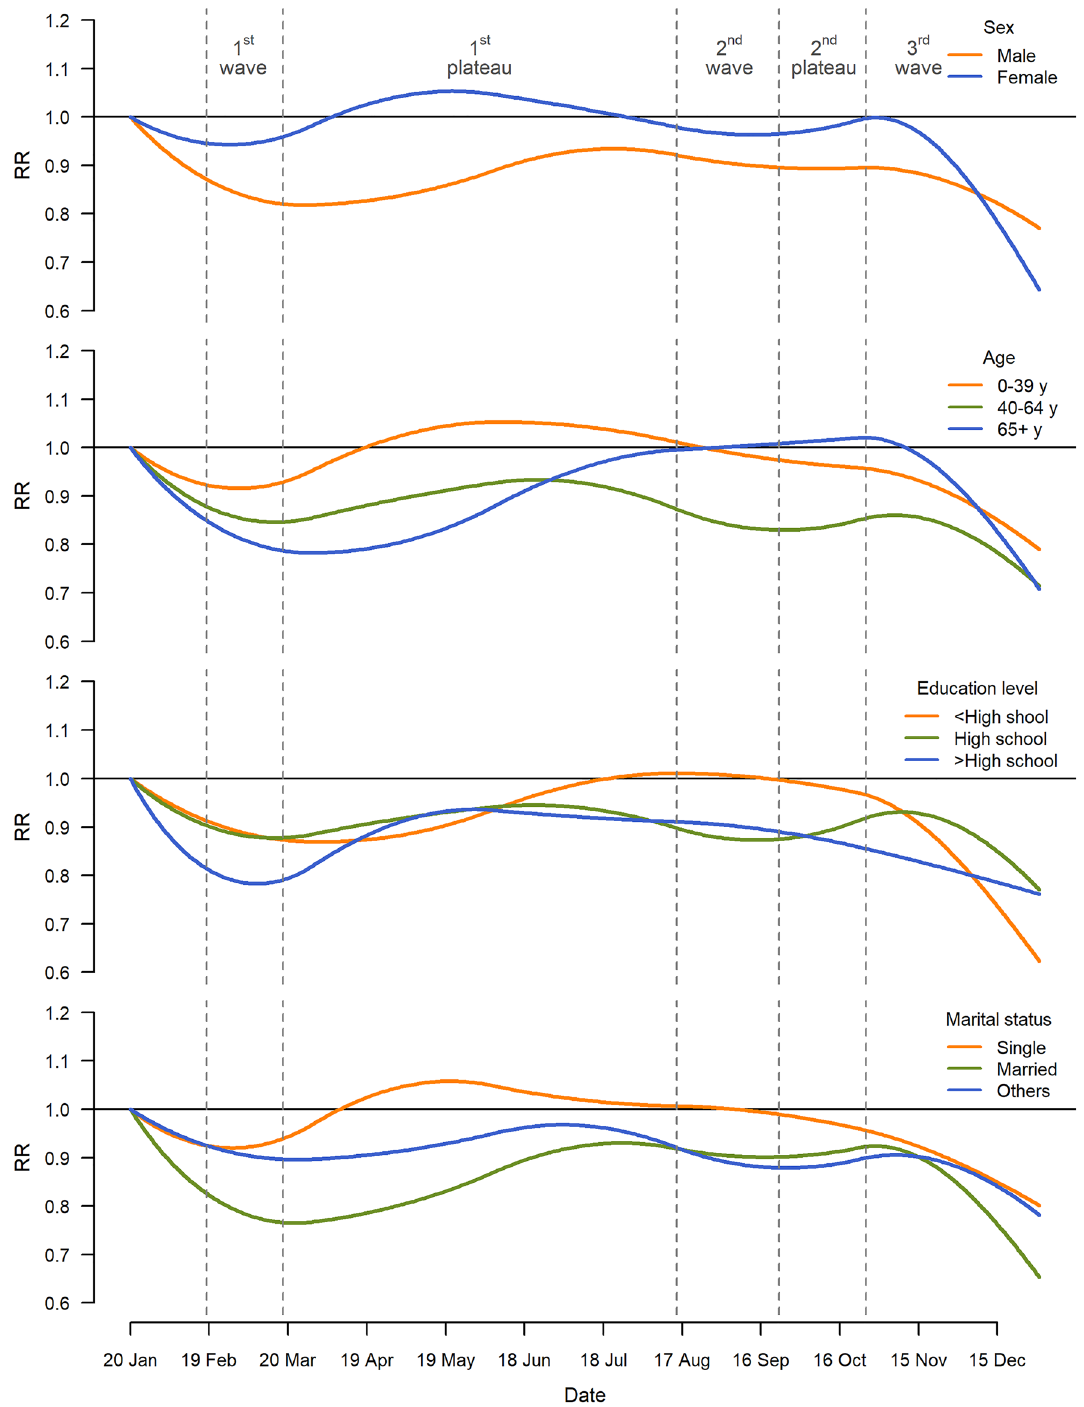
Figure 3. Temporal trend in excess risk (relative risk, RR) of suicide in Korea by sex, age, education level, and marital status during the period January 20–December 31, 2020. In terms of marital status, others include divorced and widowed